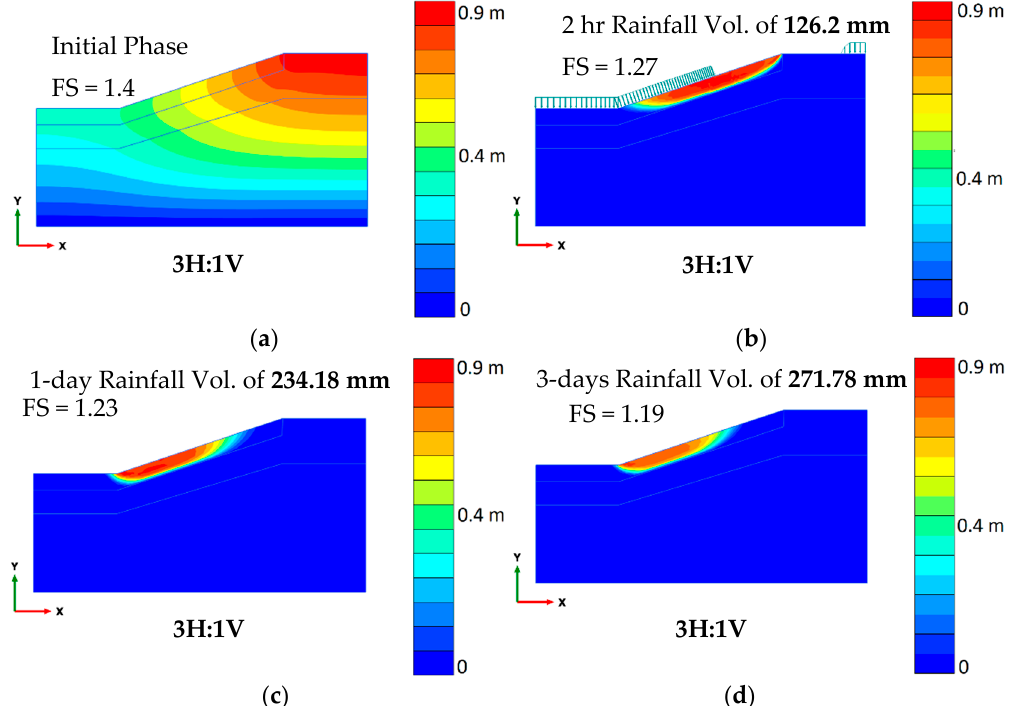
Figure 11. Case IV; changes in slip surface for 126.2 mm/h rainfall volume for 3H:1V slope ratio: ( a ) prior to rainfall, ( b ) 2-h rainfall duration, ( c ) 1-day rainfall duration, ( d ) 3-day rainfall duration.